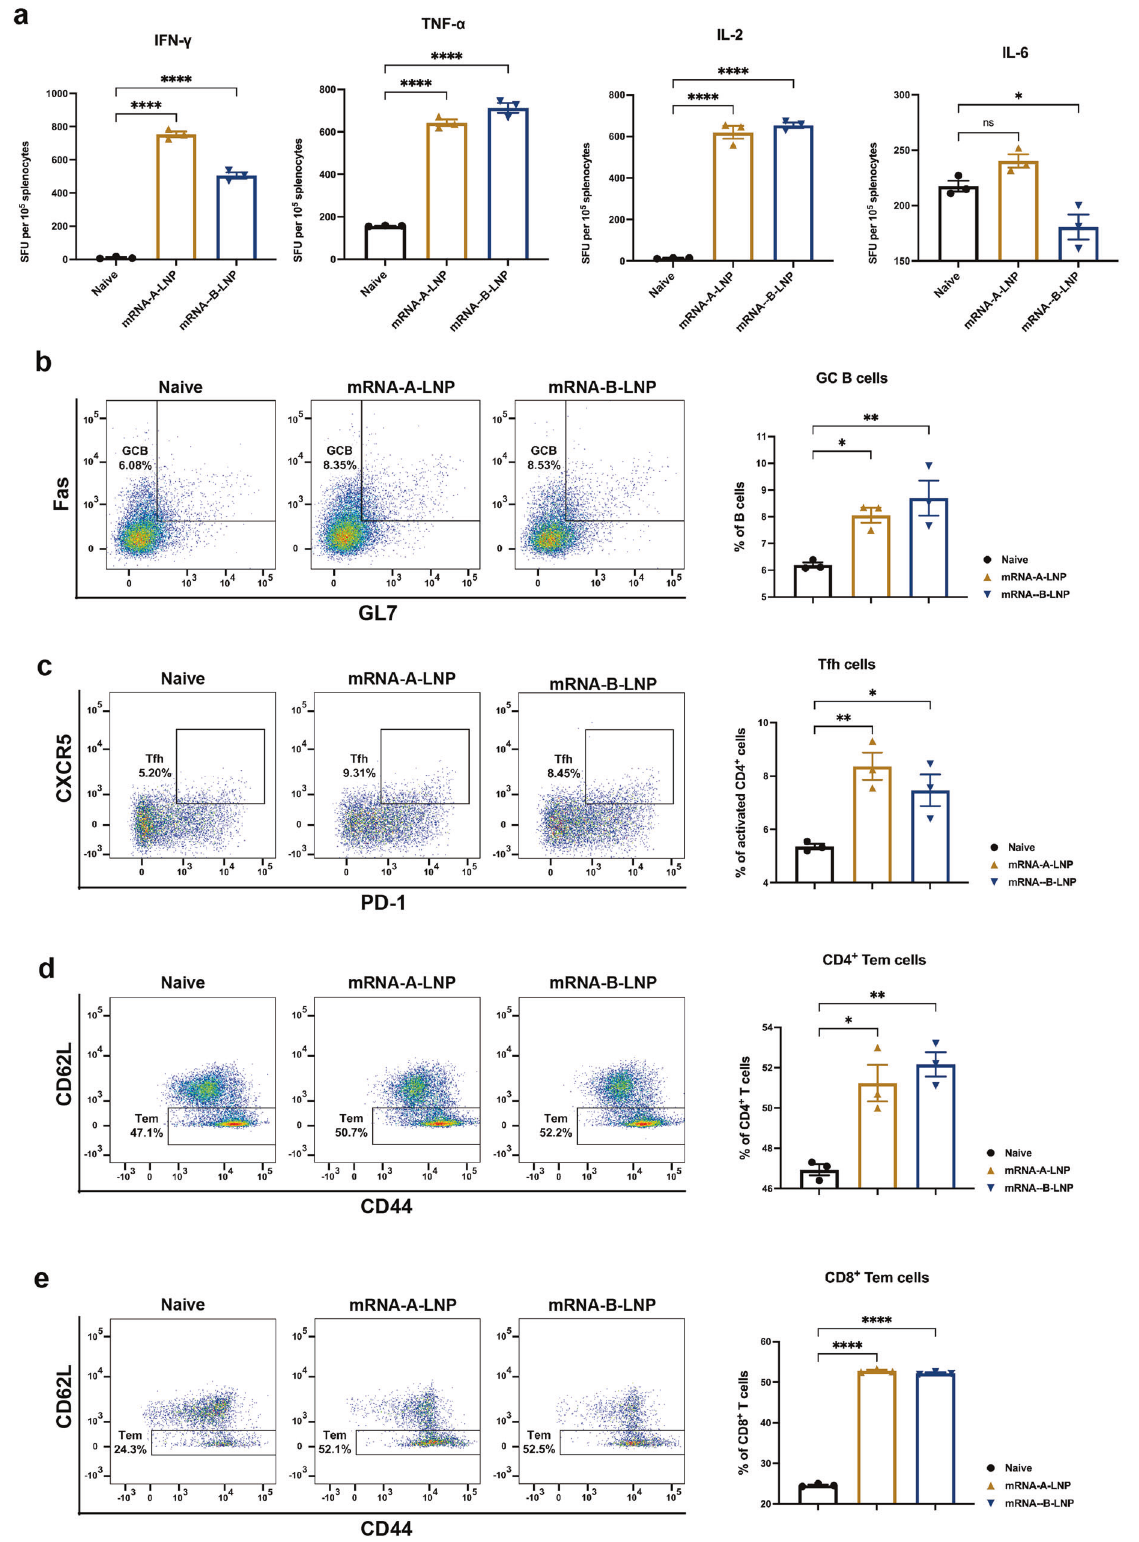
Fig. 3 MPXV-Speci fi c Cell Response in mRNA-A-LNP and mRNA-B-LNP-Vaccinated Mice. a ELISPOT detection of IFN- γ , TNF- α , IL-2 and IL-6 release from MPXV-A29L, A35R, M1R, and B6R peptide stimulated splenocytes 30 days after immunization. SFU spot forming units. Data are shown as mean ± SEM. b , c MPXV-speci fi c GC B cells ( b ) and Tfh cells ( c ) in DLNs were detected by fl ow cytometry. d , e MPXV-speci fi c CD4 + ( d ) and CD8 + ( e ) Tem cells in the spleen were detected by fl ow cytometry. Signi fi cance was calculated using one-way ANOVA with multiple comparison tests (n.s., not signi fi cant; * p < 0.05, ** p < 0.01, *** p <